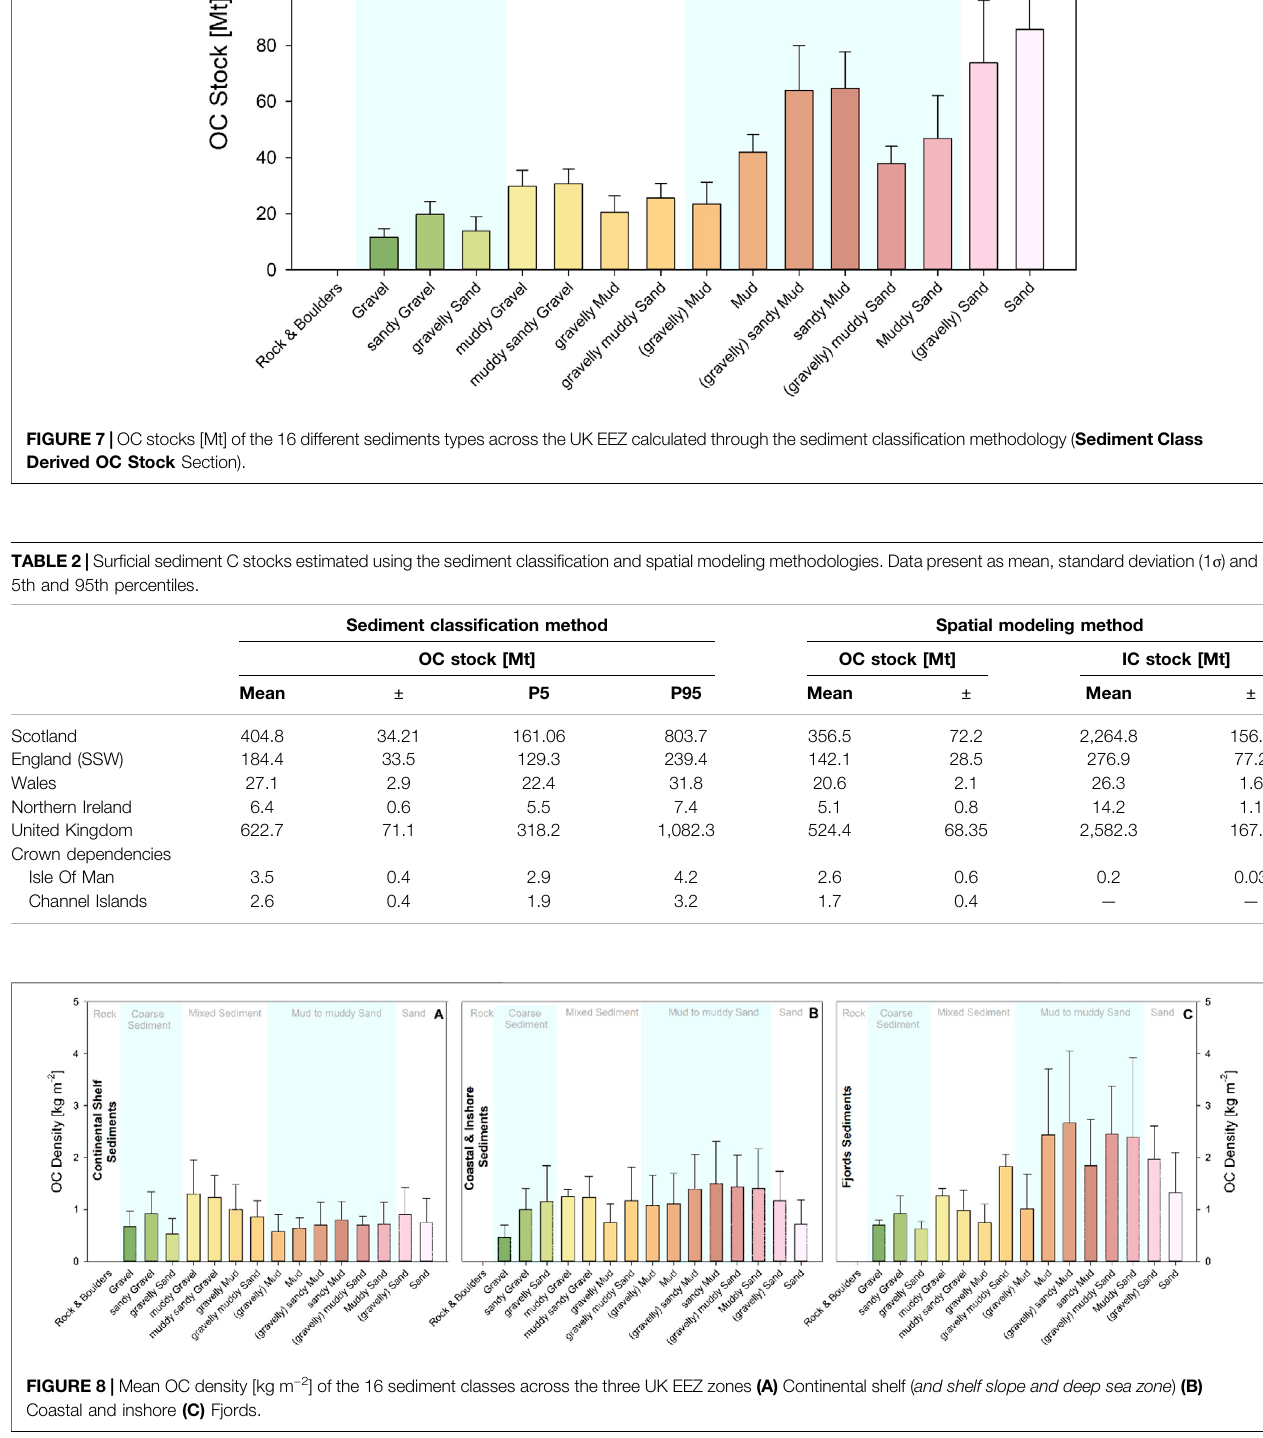
Frontiers in Earth Science |